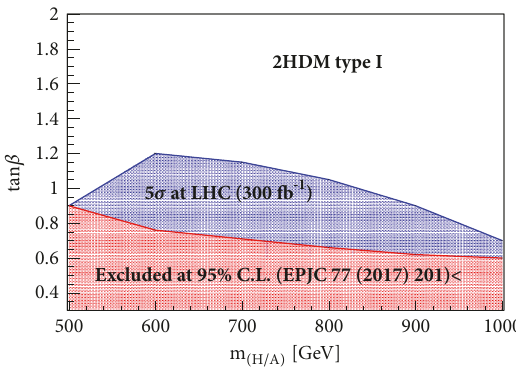
Figure 6: The signal significance at 300 𝑓𝑏 −1 as a function of the Higgs boson mass for different values of tan 𝛽 .